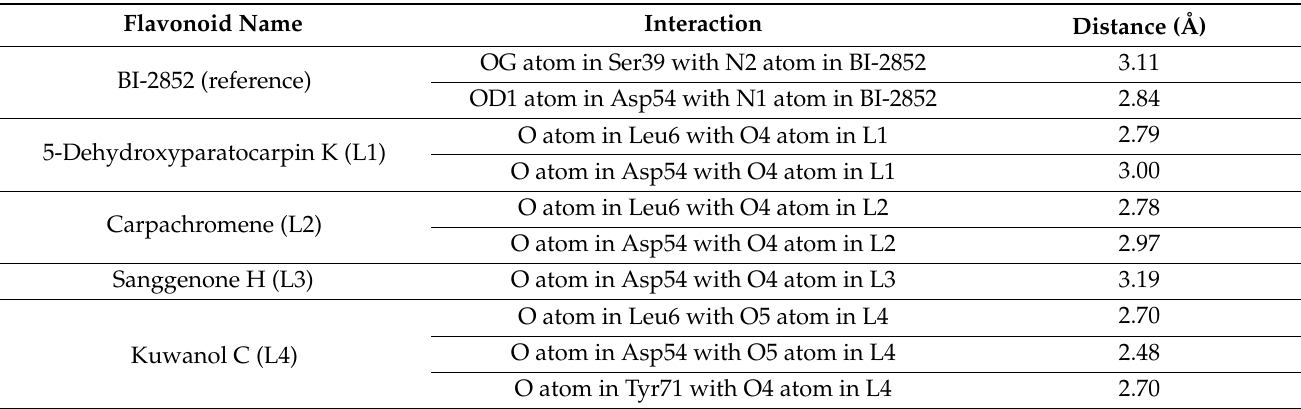
Table 4. Intermolecular hydrogen-bond interactions of 4